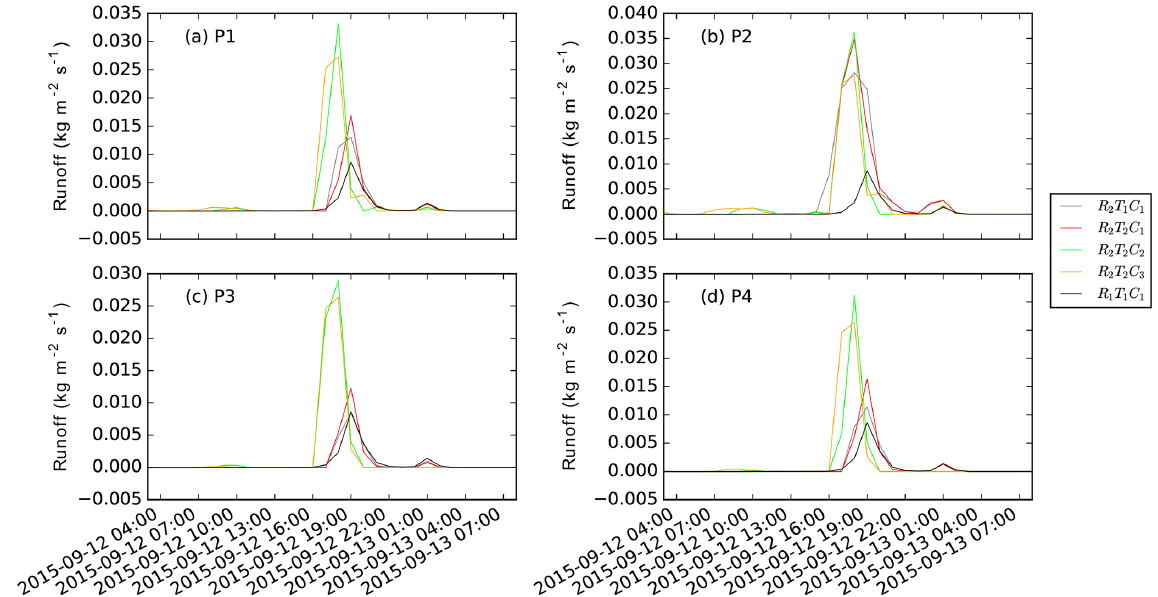
Figure 14. Runoff time series between 03:00UTC on 12 September 2015 and 08:00UTC on 13 September 2015 at (a) P1, (b) P2, (c) P3, and (d) P4.